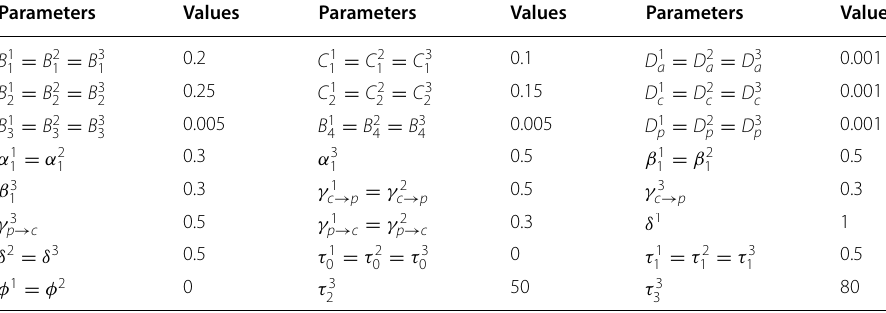
Table 6 Parameters values for the numerical simulations